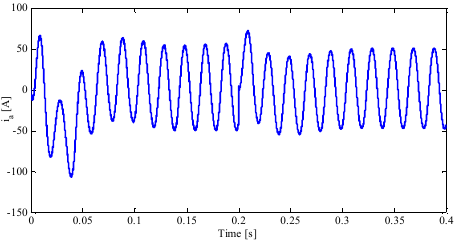
Figure 13. MMC current of phase “a” with parameter variations.